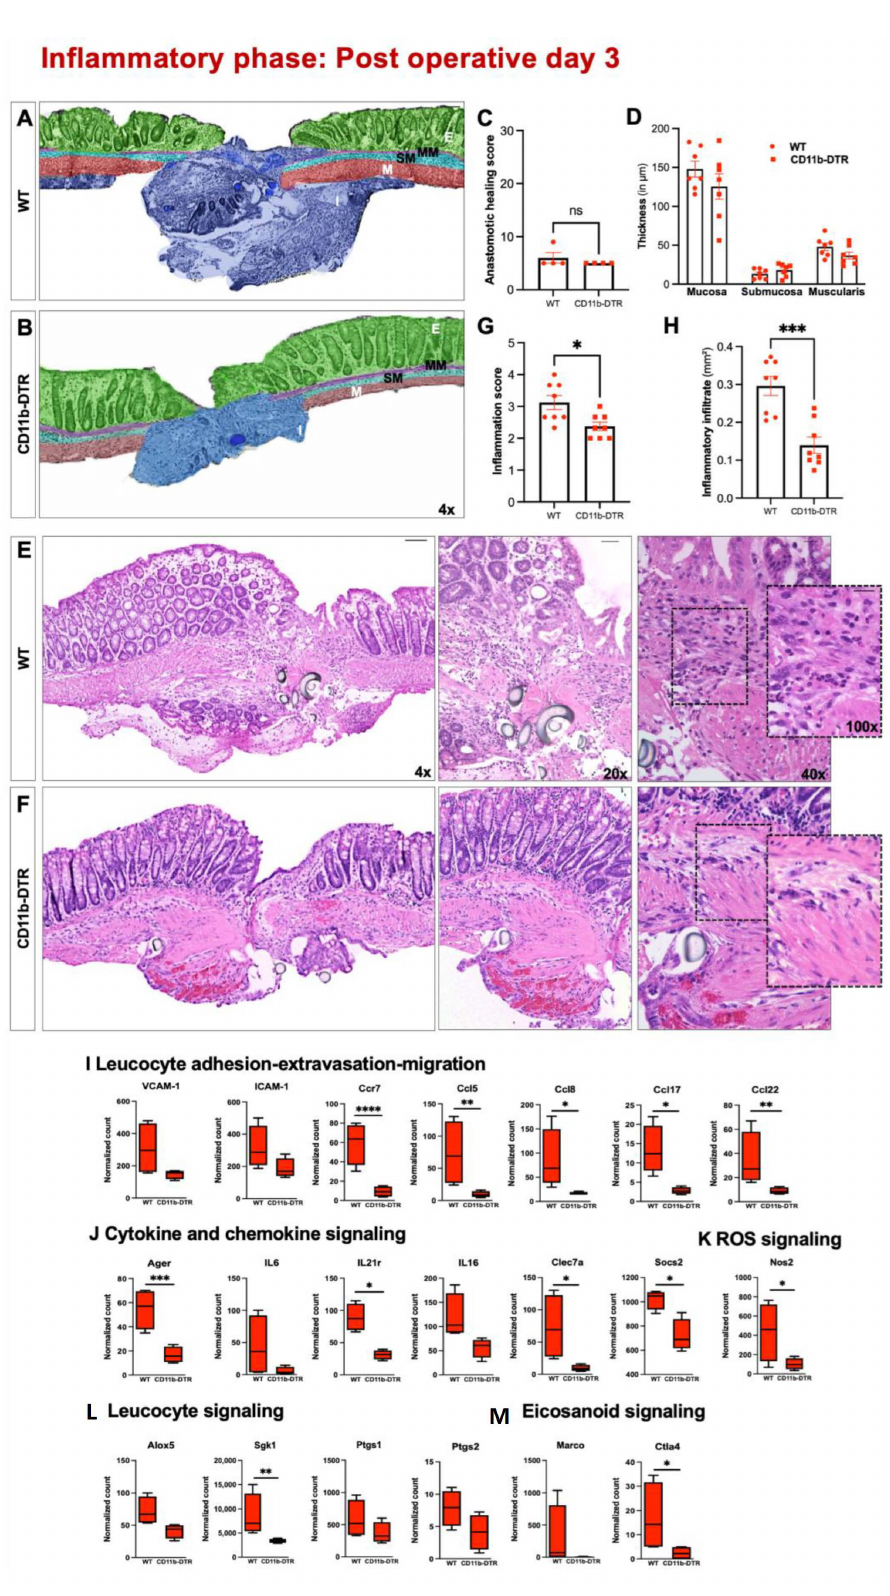
Figure 4. Intestinal anastomotic healing during the inflammatory phase. Multicolor stained sections of anastomotic healing (AH) at postoperative day 3 in ( A ) wild type (WT) and ( B ) CD11b-diphtheria toxin receptor (DTR) mice. E = epithelium (green); MM = muscularis mucosae (purple); SM =